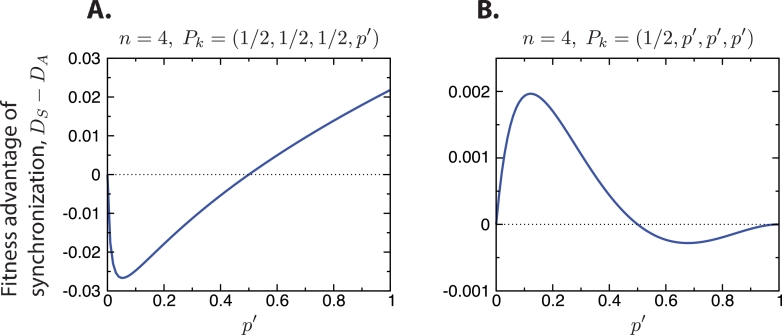
The difference in the steady-state fitnesses of the synchronously and asynchronously dividing subpopulations is shown for two choices of P→ for n=4. The dynamics are in discrete time. When multicellularity is selected for (p′ > 1/2 in this figure), synchronization of cell divisions is the more successful phenotype in some cases (A), and asynchronization in others (B).